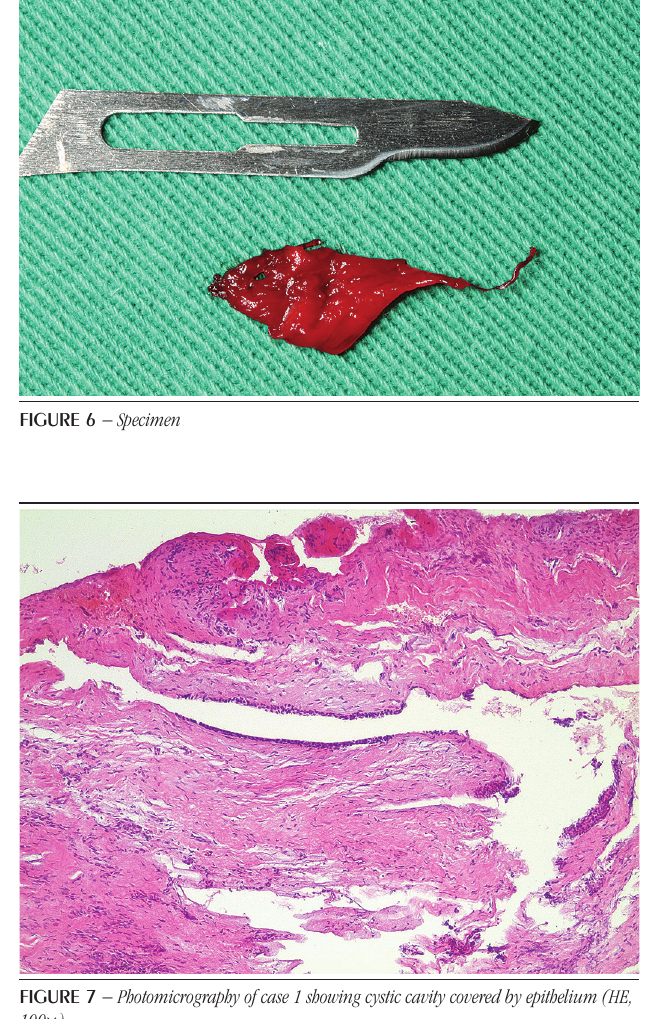
figurE 8 − Cystic cuboidal epithelial lining with few layers and fibrous connective tissue capsule (HE, 400×) HE: hematoxylin and eosin.